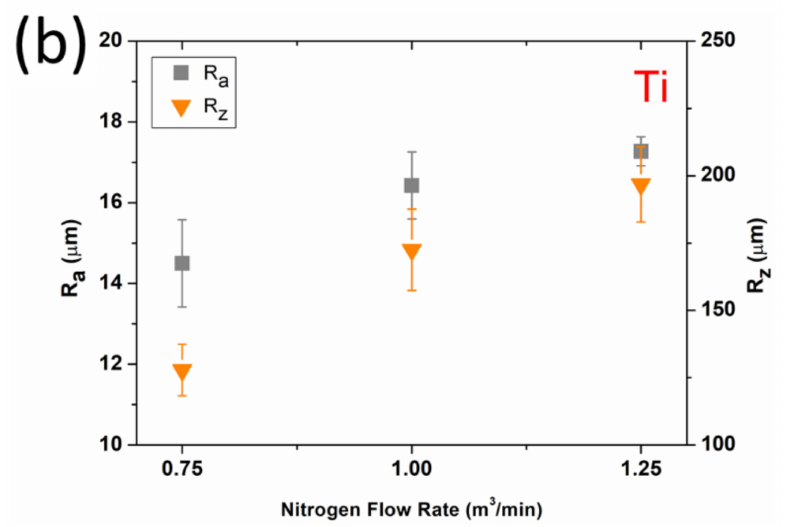
Figure 7. Surface roughness of Al ( a ) and Ti ( b ) coatings. Vickers hardness values (HV0.5) of the WS coatings are shown in Figure 8, along with the plate substrate (AZ91E) microhardness measurements. The results show decreasing microhardness as a function of increasing NFR. This effect is visible for both Al and Ti. Samples formed at the highest temperature (using 1.0 m 3 /min NFR for Al and 0.75 m 3 /min for Ti) exhibited the highest microhardness. For low NFR in WS deposition, spray particles formed at a higher processing temperature and thermally softened compared with other WS conditions, producing more extensive deformation upon impact associated with work hardening. Strain hardening was also observed in cold spraying (CS), a related coating application method [40–42]. The microhardness increase was attributed to the strain hardening phenomenon during deposition [43,44].